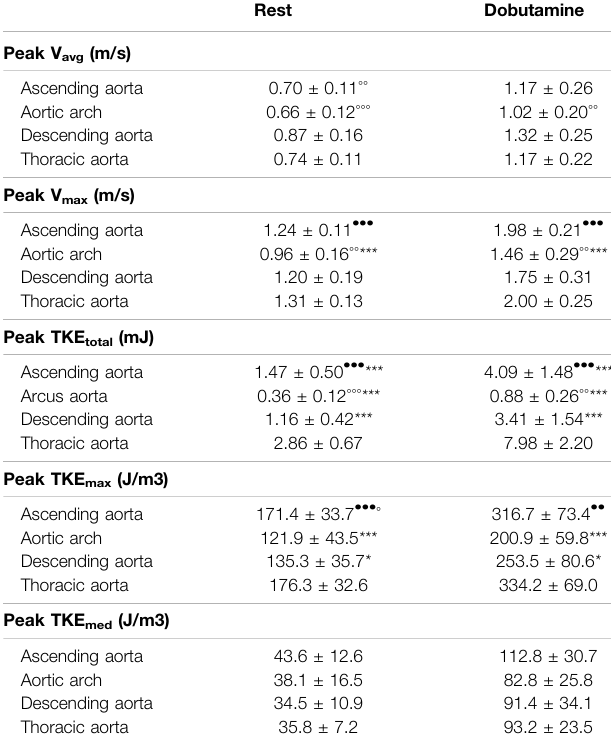
TABLE 4 | Parameter difference between aortic regions. Rest